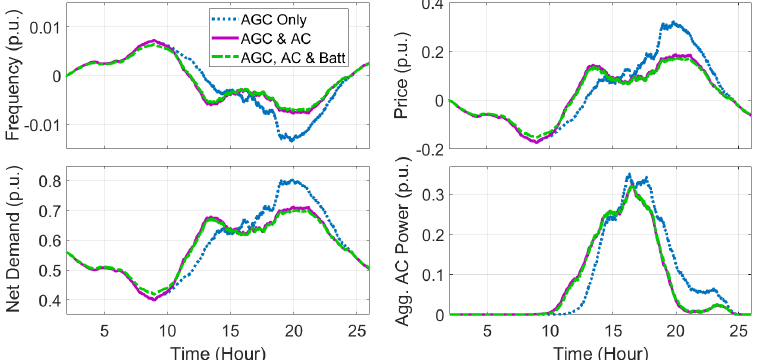
Figure 20. Daily grid simulation using AGC, AC, and battery storage, and CAISO demand and renewable energy data. renewable energy